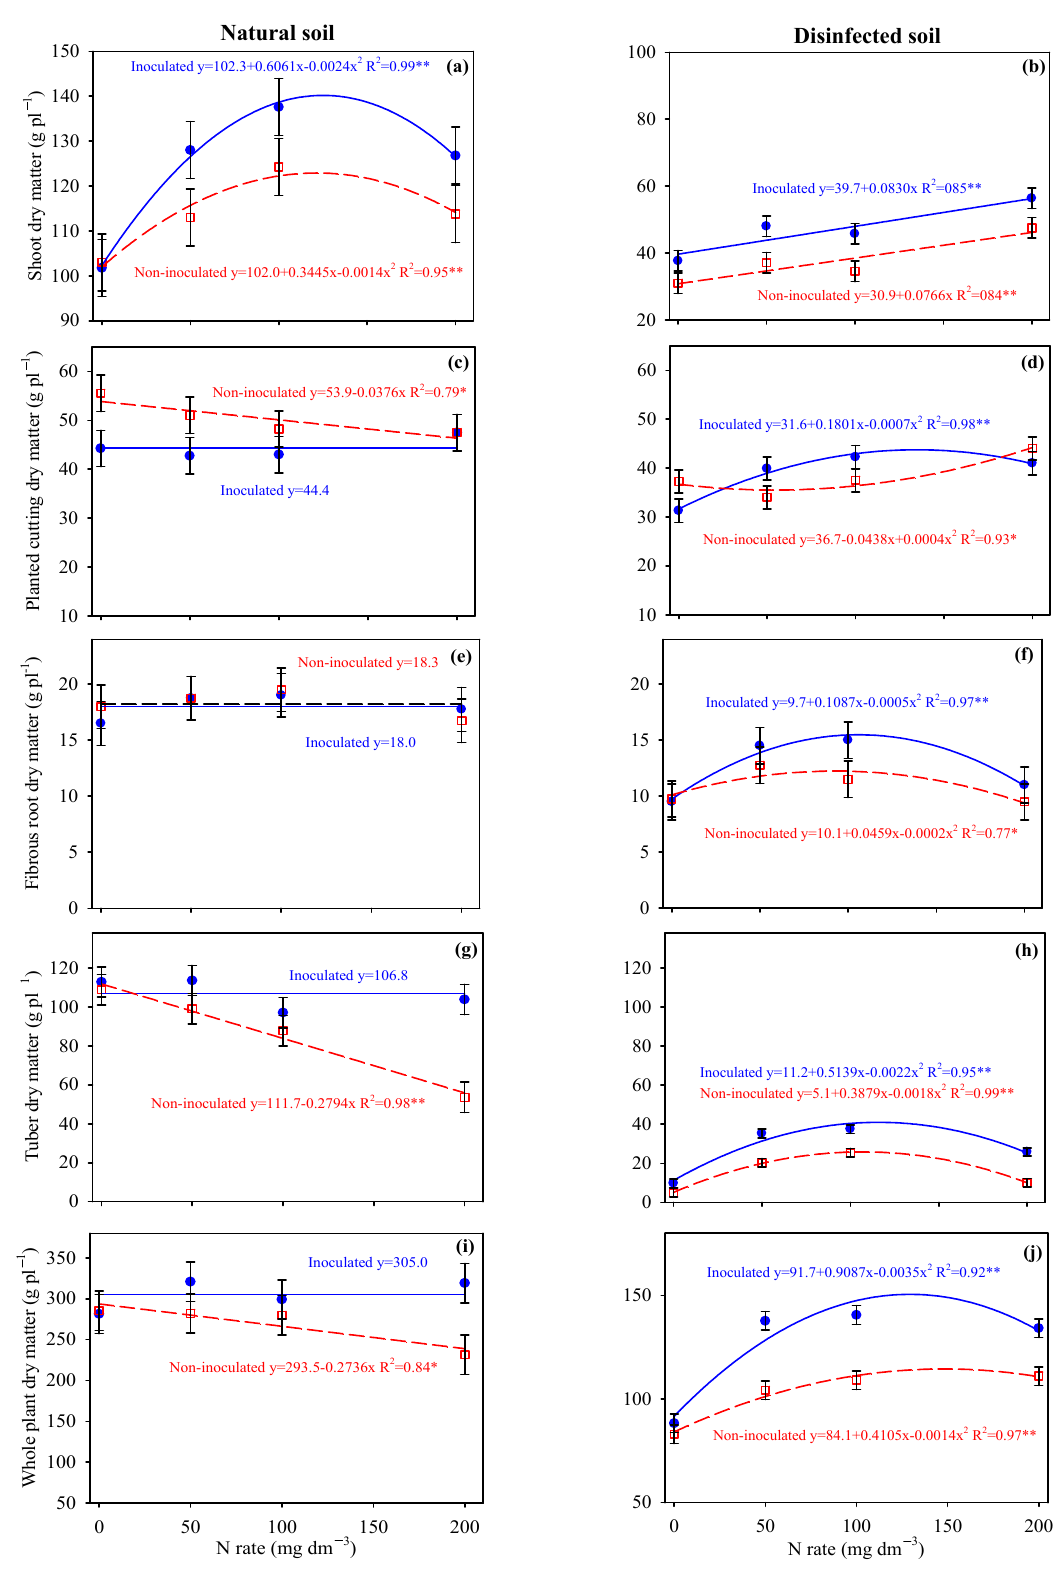
Figure 3. Dry matter accumulation in the shoot ( a , b ), planted cutting ( c , d ), fibrous root ( e , f ), tuber ( g , h ), and whole plant ( i , j ) of cassava in response to N application rates and A. brasilense inoculation in natural and disinfected soil. Bars represent the least significant difference between A. brasilense inoculation in the same N rate at p < 0.05 according to the LSD test. * p < 0.05; ** p <